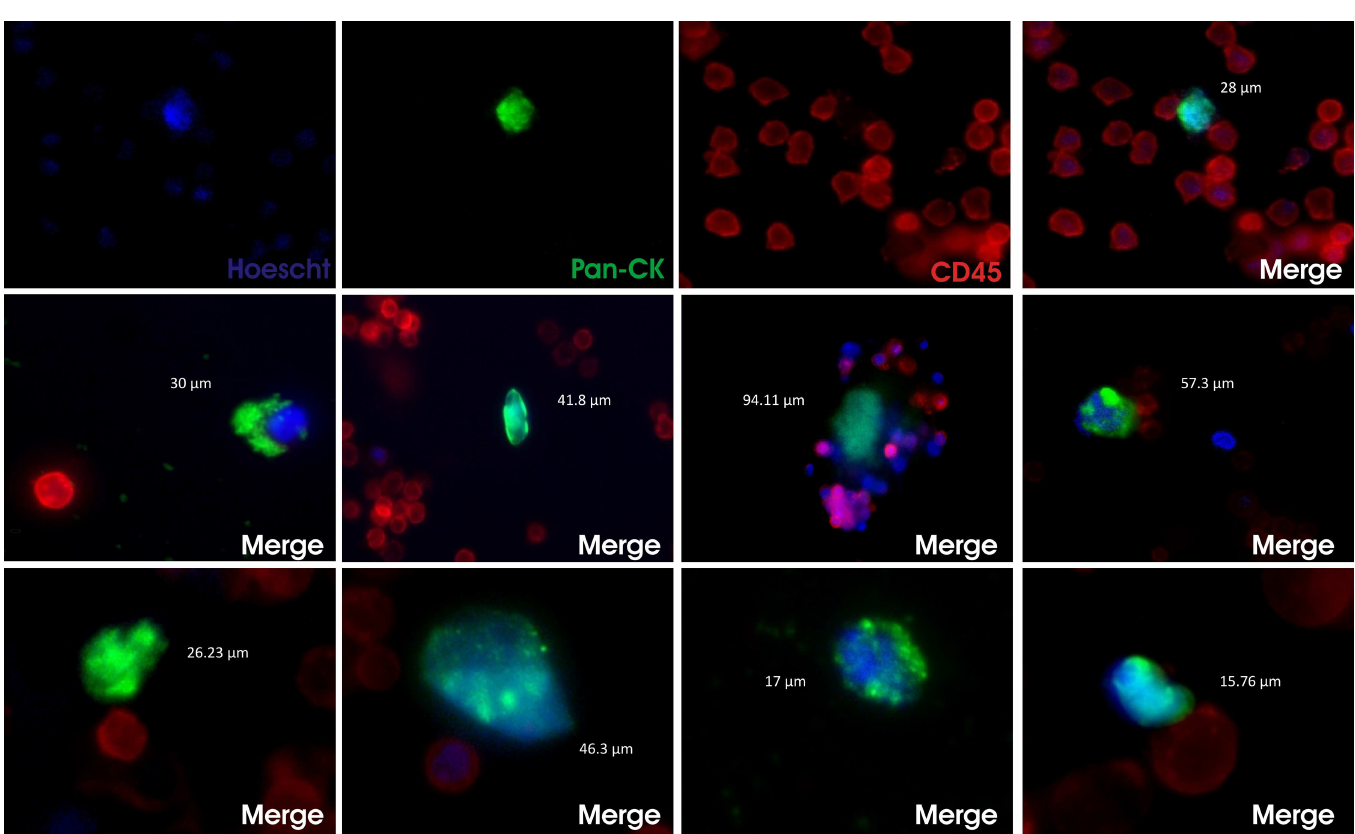
Fig 5. CTCs isolated with magnetic beads from blood from patients with metastaticcancer. Representative immunofluorescence for Hoechst (blue, for nuclei staining), pan-cytokeratins (green), CD45 (red) and merge of CTC isolated from a patient with metastatic breast cancer (upper panel). Merge for indicatedstaining of CTCs isolated with anti-EpCAM, anti-EGFR or anti-FGFR magnetic beads. The size of each CTC is indicated in μ m.